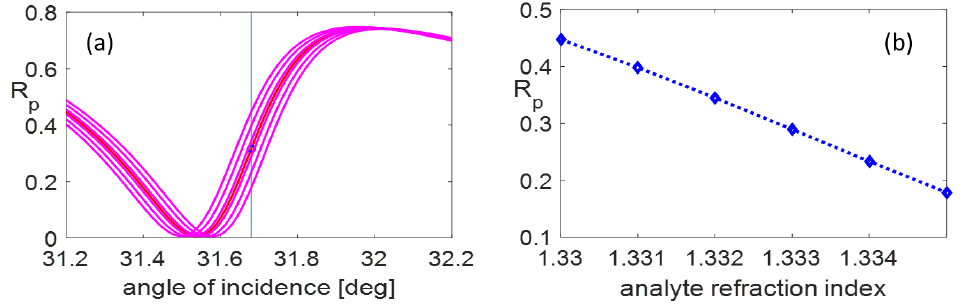
Figure 10. Illustrations of the sensitivity analysis: ( a ) details of reflectance curves corresponding to the scale of analyte refractive index in figure ( b ) with marked reference incidence angle; and ( b ) linearity of the R p vs. n a